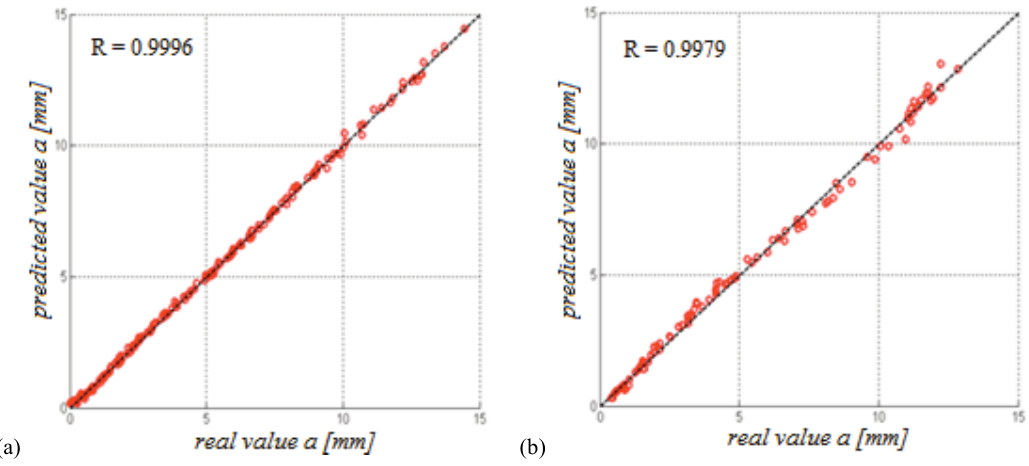
Fig. 10. Correlation between the values obtained in the laboratory and by using ANN